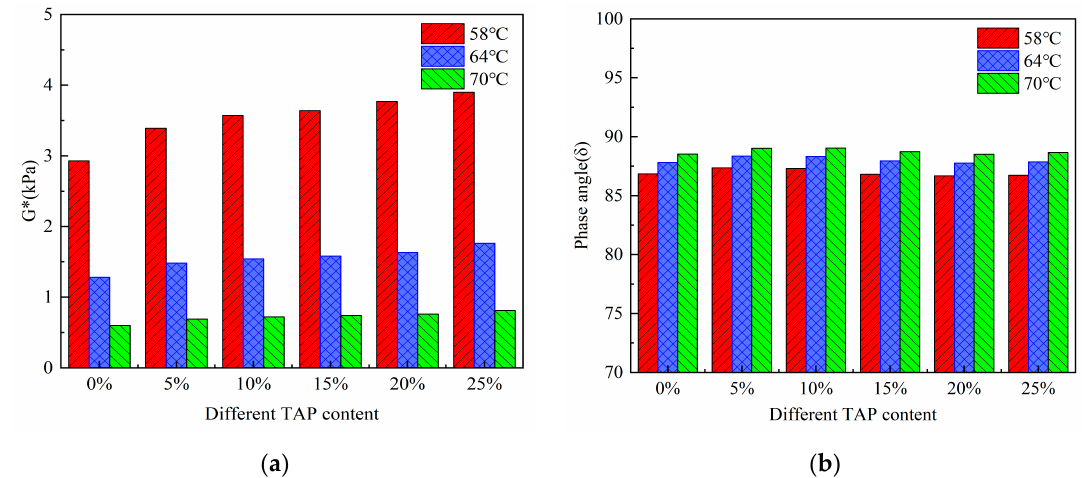
Figure 2. DSR test results: ( a ) complex shear modulus, and ( b ) phase angle.